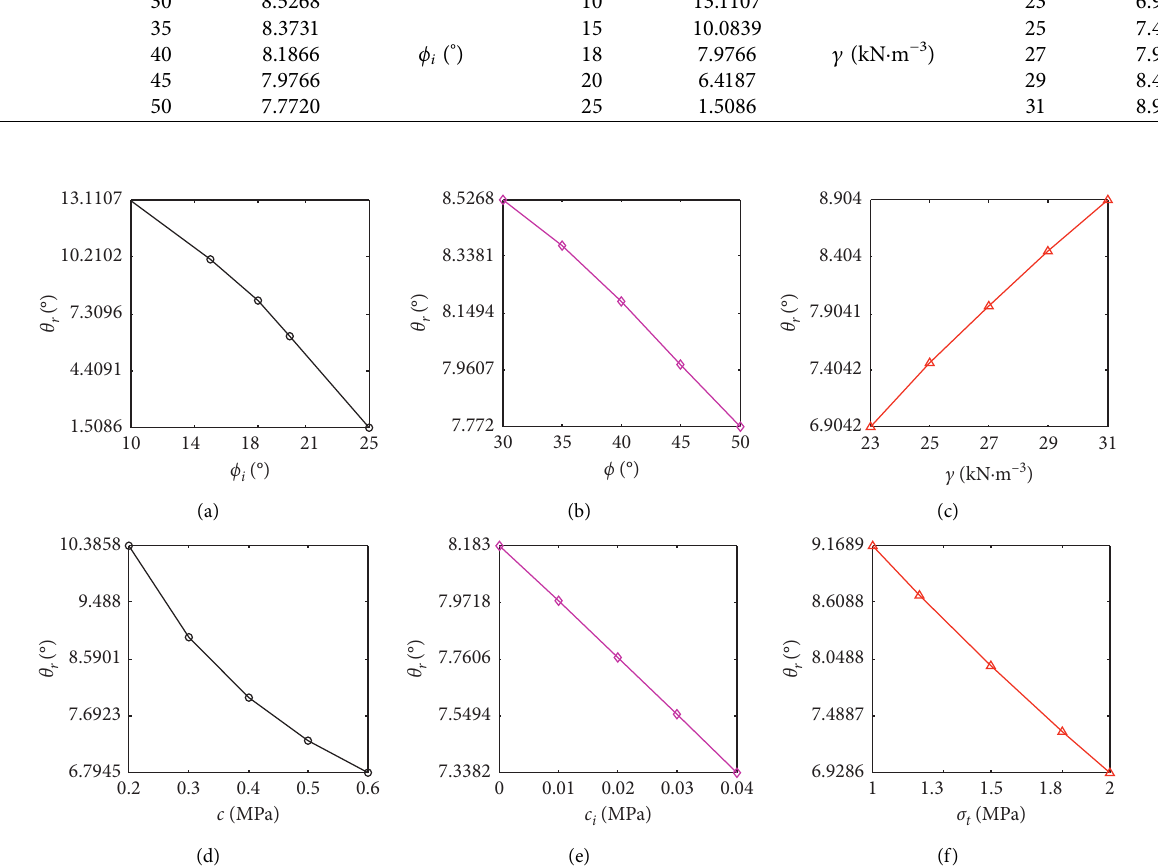
Table 8: Sensibility analyses of the mechanical parameters of the rock mass of the slate slope in South Anhui. Parameters Values θ r ( ° ) Parameters Values θ r ( ° ) Parameters ϕ ( ° )